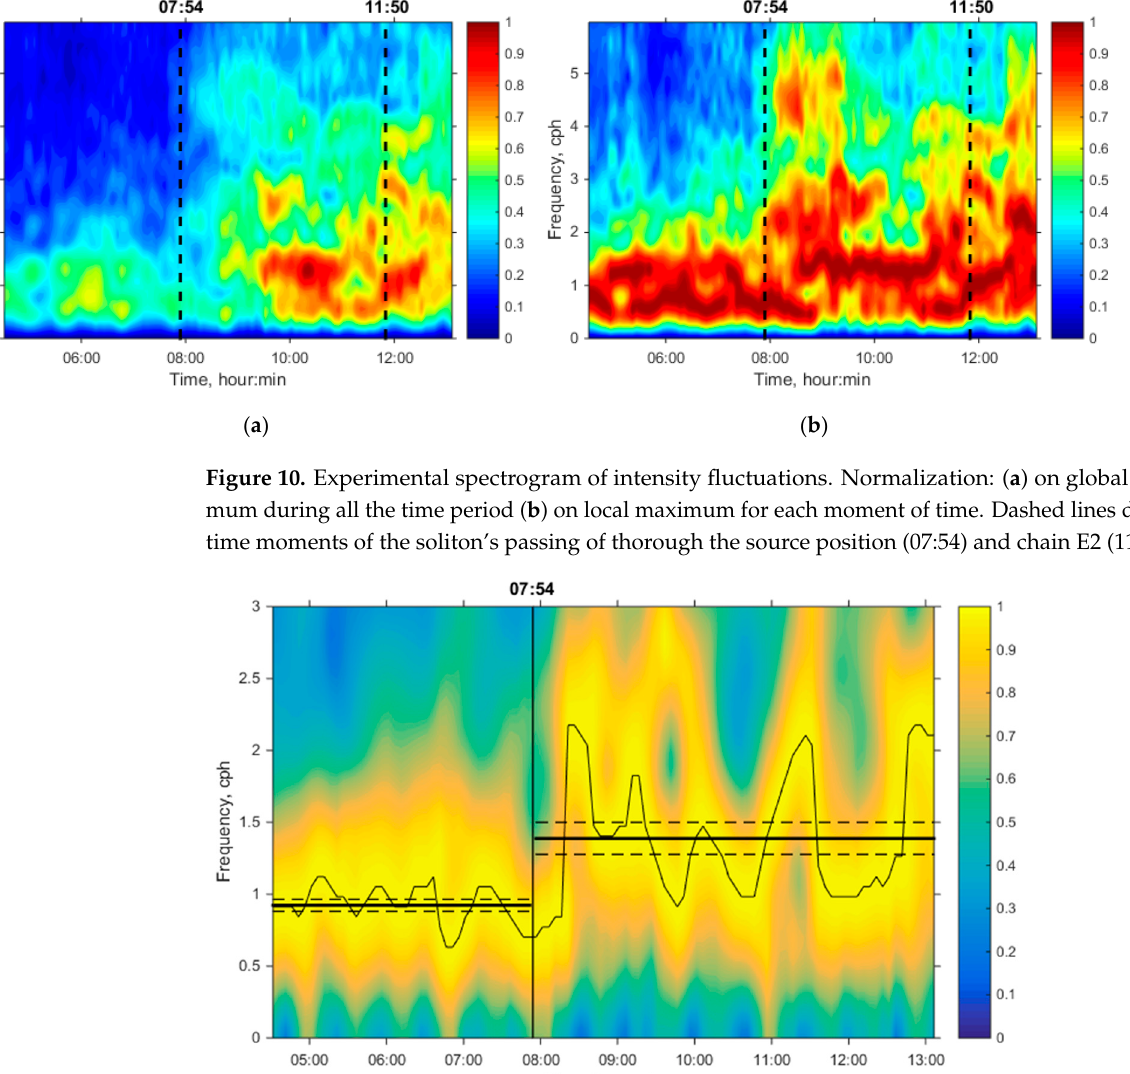
Figure 10. Experimental spectrogram of intensity fluctuations. Normalization: ( a ) on global maxi- mum during all the time period ( b ) on local maximum for each moment of time. Dashed lines denote time moments of the soliton’s passing of thorough the source position (07:54) and chain E2 (11:50).